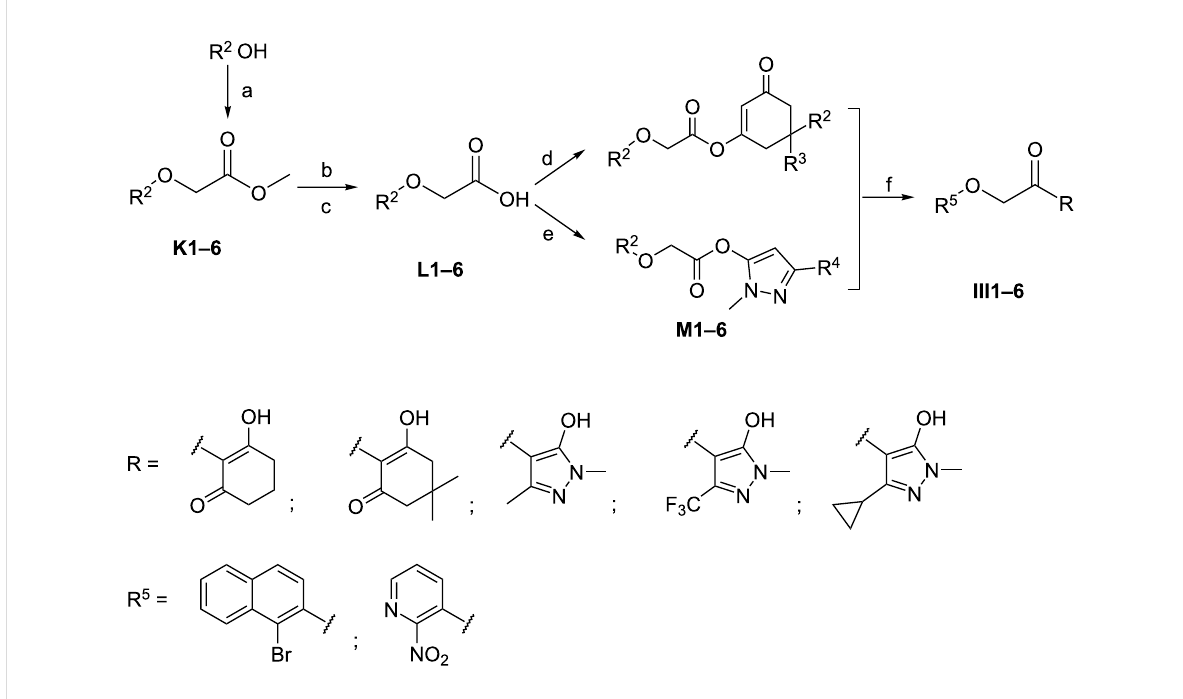
Scheme 3: Synthetic route of the title compound III . Reagents and conditions: (a) methyl chloroacetate, K 2 CO 3 , CH 3 CN, 65 °C; (b) K 2 CO 3 , H 2 O, 65 °C; (c) aqueous HCl solution (10%), rt; (d) substituted 1,3-cyclohexanediones, EDCI, DMAP, DCM, rt; (e) substituted 1,3-dimethyl-1 H -pyrazol-5-ol,